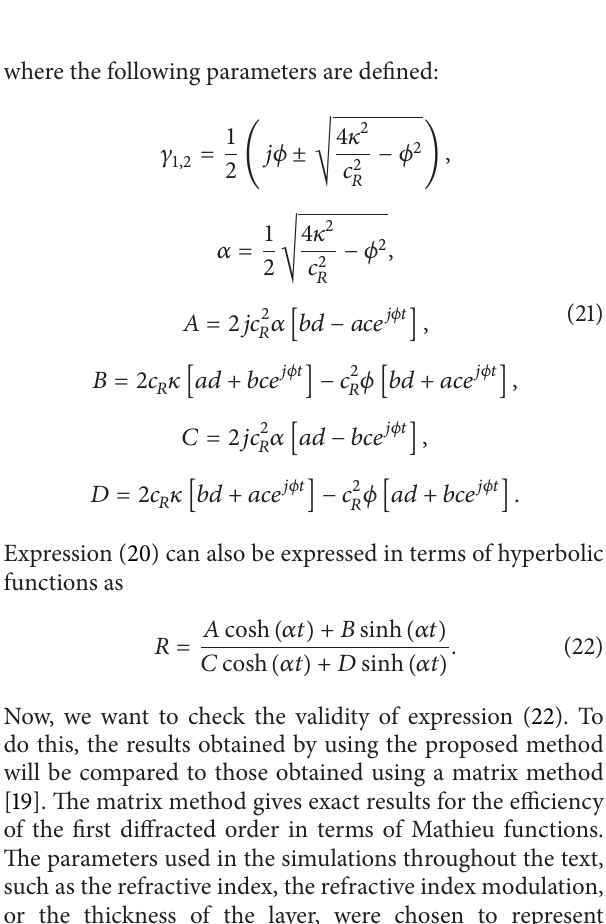
Figure 3: Diffraction efficiency of a reflection grating embedded in air with thickness of 25 𝜇 m, spatial frequency of 4000 lines/mm, average refractive index 𝑛 2 = 1.5 , and refractive index modulation of